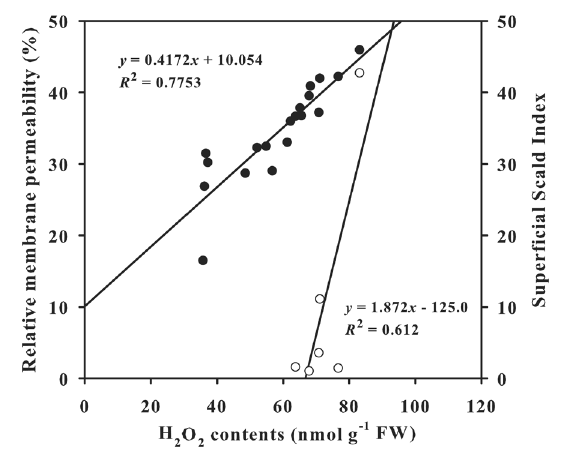
Fig. 5: Correlation between H 2 O 2 content and the relative memebrane permeability of the peel ( ● ), and between H 2 O 2 content and scald index (  ) in ‘Wujiuxaing’